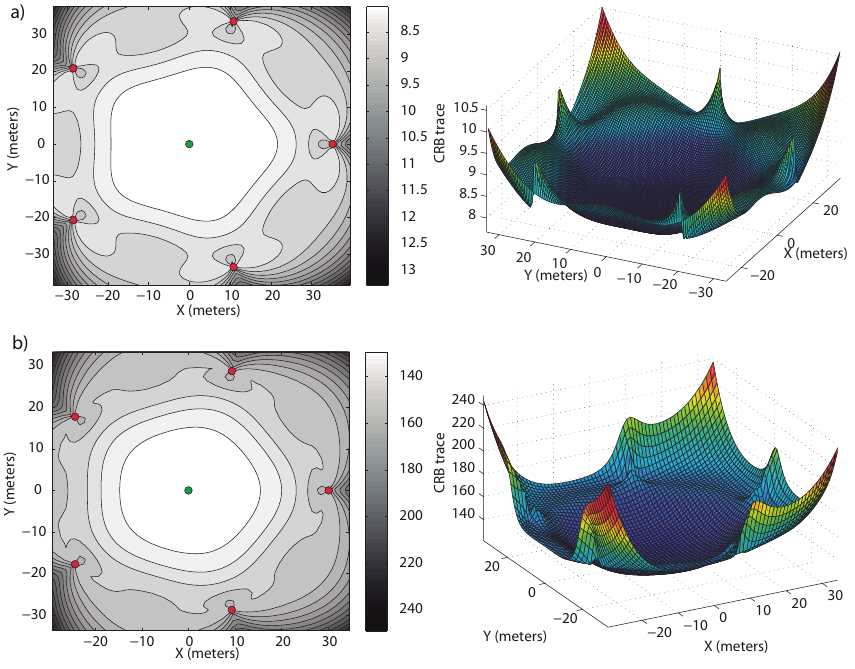
Figure 2. Optimal surface sensor formations for a target depth of 50 meters, σ = 0 . 05 rad and different values of η . ( a ) η = 0 ; ( b ) η = 0 . 05 and γ = 1 . On the left-hand side, the level curves of tr ( CRB ) D in ℜ 2 are shown—lighter regions indicate higher accuracy—and on the right-hand side, their magnitudes in 3D for D .